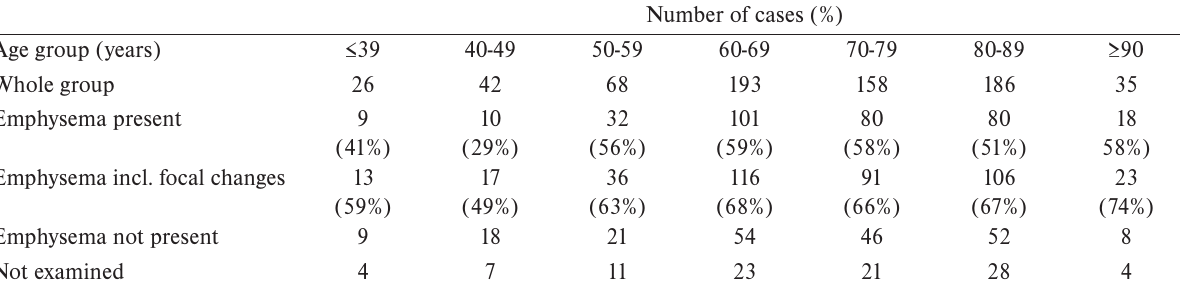
Table 4. The incidence of microscopically proven emphysema according to